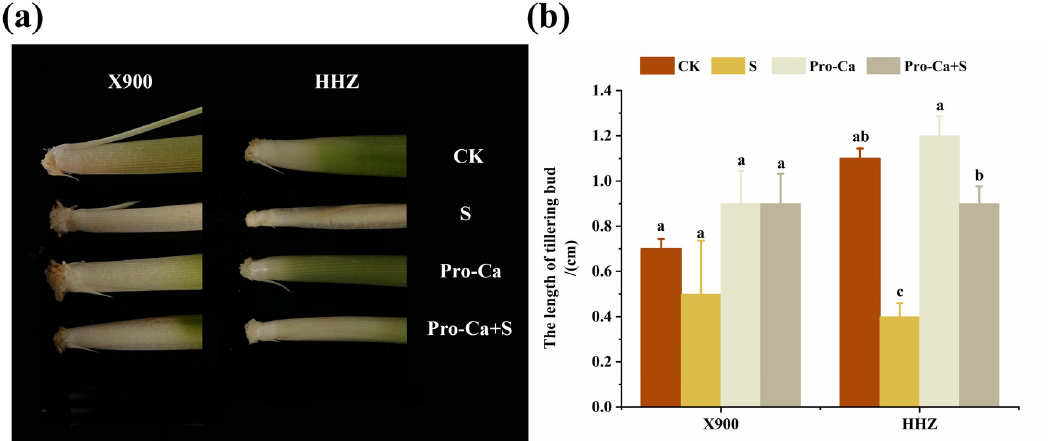
Fig 2. Effect of exogenous prohexadione-calcium (Pro-Ca) on the length of the axillary buds of the fifth leaf of rice under salt stress. Abbreviations: CK (water spraying + 0% NaCl), S (water spraying + 0.3% NaCl), Pro-Ca (100 mg � L -1 Pro-Ca leaf spraying + 0.3% NaCl), and Pro-Ca + S (100 mg � L -1 Pro-Ca leaf spraying + 0.3% NaCl). The numerical value represents the mean ± SE ( n = 3), and different lowercase letters indicate significant differences according to Duncan’s test ( p < 0.05). https://doi.org/10.1371/journal.pone.0279192.g002 improved by 79.05% and 273.10%, respectively. These results indicated that Pro-Ca signifi- cantly alleviated the Tr, WUE, AMC, and SPAD values of the two varieties. Meanwhile, exoge- nous spraying of Pro-Ca reduced the Ci of the rice (Fig 3).